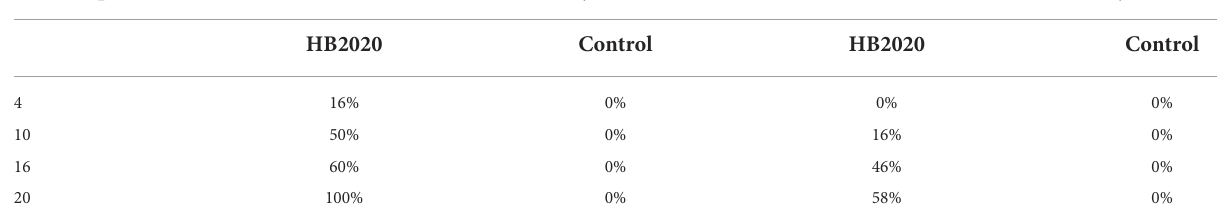
TABLE 5 The cumulative morbidity and mortality of the HB2020 infected chickens. Time (Wpi) Cumulative morbidity Cumulative